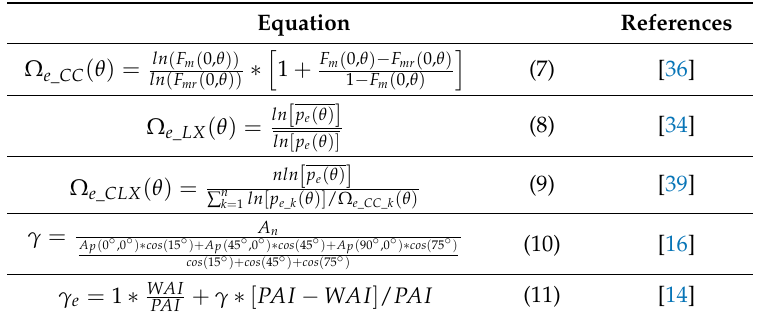
Table 1. The Ω e and γ e estimation formulae used in this study. F m ( 0, θ ) is the measured total gap fraction of the canopy element at zenith angle θ (i.e., accumulated gap fraction from the largest to the smallest gaps), F mr ( 0, θ ) is the total gap fraction after removing those large gaps resulting from the nonrandom distribution of the canopy element [14,36,41], p e ( θ ) is the mean canopy element gap fraction of all segments at θ , ln [ p e ( θ )] is the mean logarithmic canopy element gap fraction for all segments at θ [34,41], n is the number of segments, p e _ k ( θ ) is the canopy element gap fraction of segment k , Ω e _ CC _ k ( θ ) is the Ω e of segment k at θ estimated by CC [35,39], and A n is half of total needle area in a shoot. A p ( 0 ◦ ,0 ◦ ) , A p ( 45 ◦ ,0 ◦ ) , and A p ( 90 ◦ ,0 ◦ ) are the shoot projection areas measured by projecting the shoot at zenith angles 0 ◦ , 45 ◦ , and 90 ◦ and azimuth angle 0 ◦ , respectively [16]. γ is the effective needle-to-shoot area ratio derived based on the A p ( 0 ◦ ,0 ◦ ) , A p ( 45 ◦ ,0 ◦ ) , A p ( 90 ◦ ,0 ◦ ) , and A n of each shoot sample. γ e is the needle-to-shoot area ratio that corrects the overestimation of γ for woody components in estimating the PAI of leaf-on forest canopies [14].